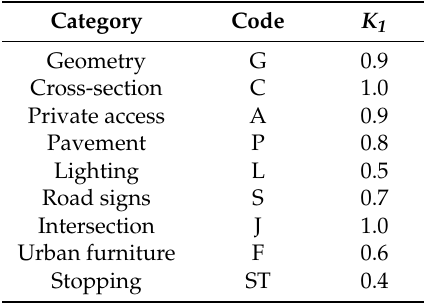
Table 1. Priority factor values of considered